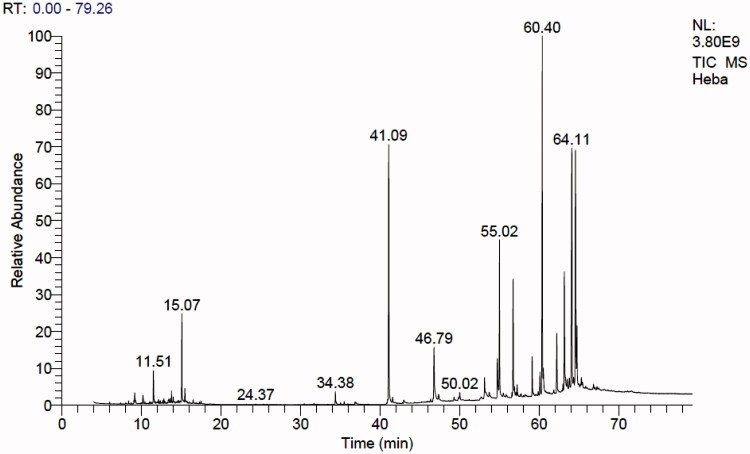
GC-MS chromatogram of n-hexane extract of A. fraxinifolius leaves.